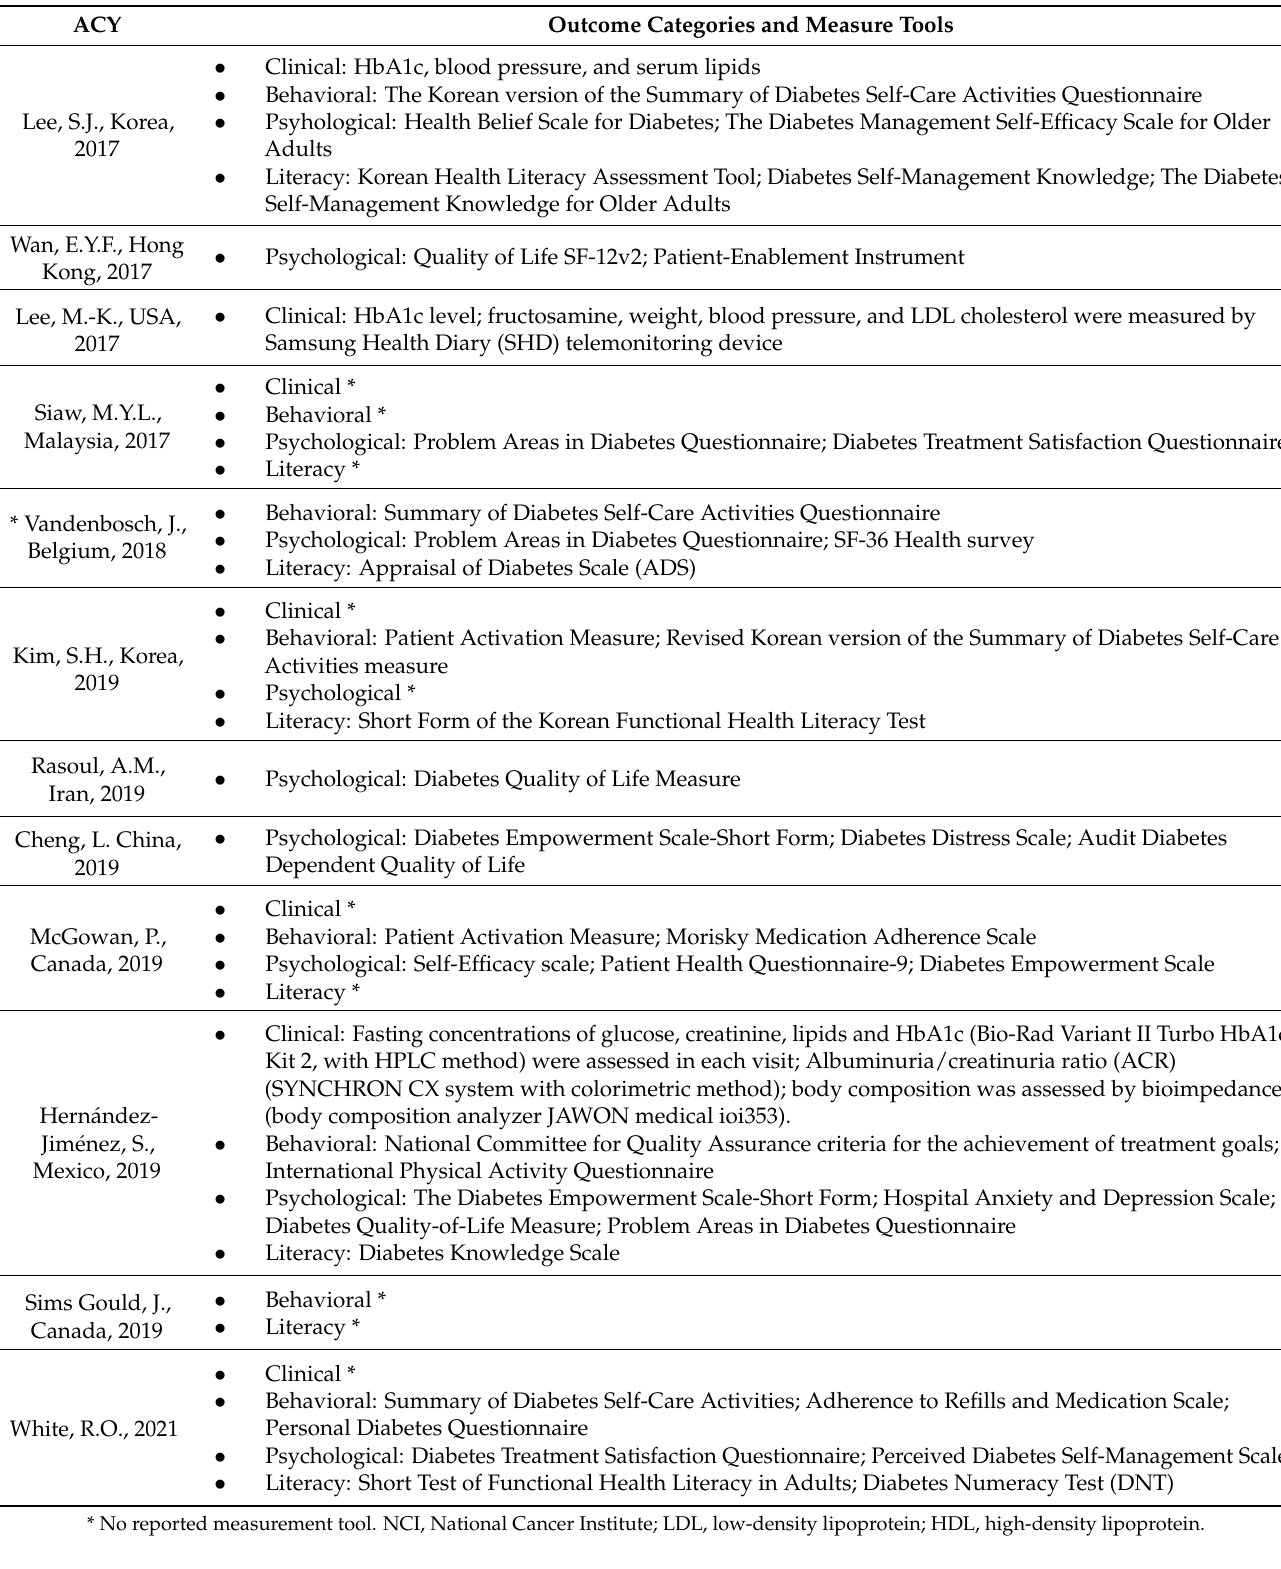
Table 3. Cont . Outcome Categories and Measure